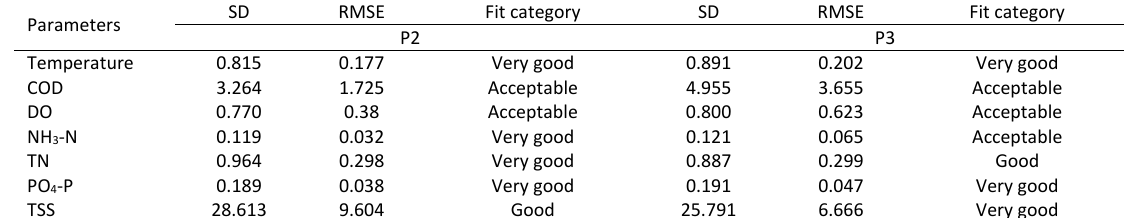
Table 6: RMSE results for all parameters